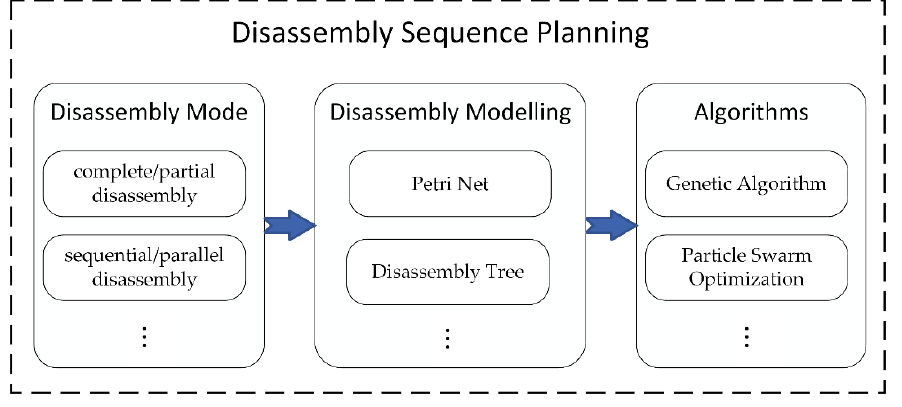
Figure 5. The three steps in DSP.